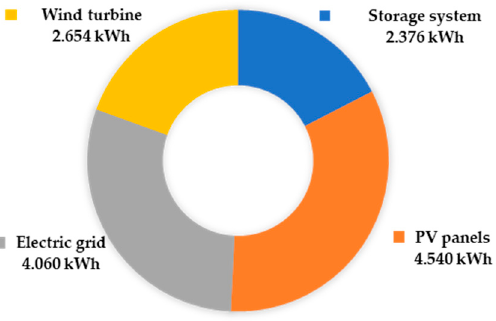
Figure 9. Distribution of electricity produced by each source. First scenario data.